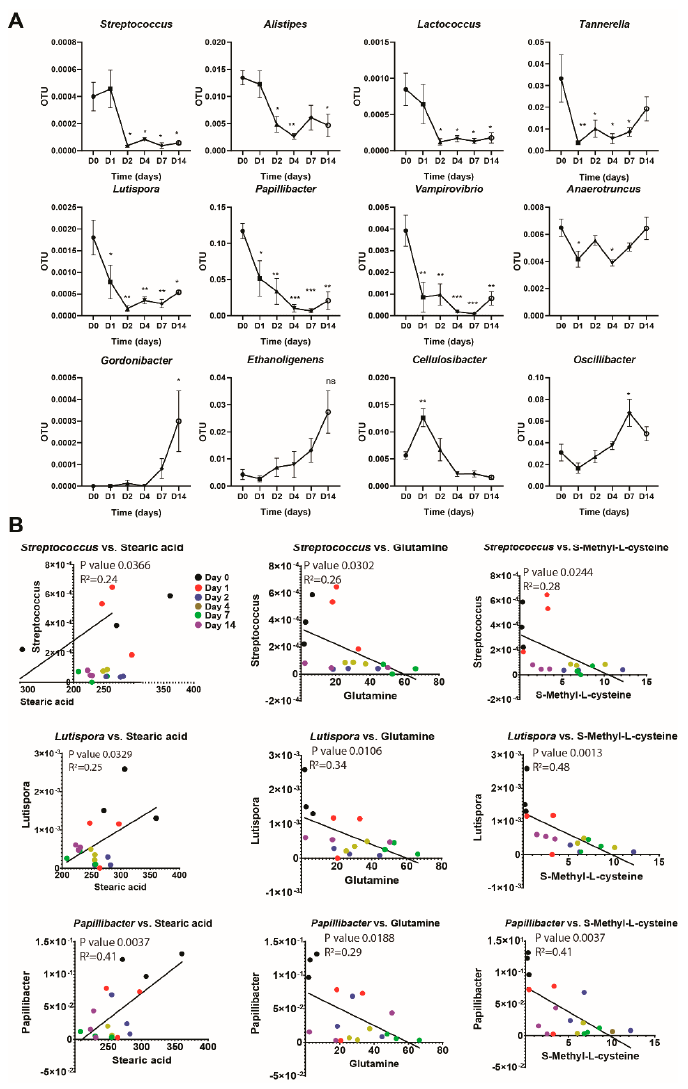
Figure 3. Changes of gut microbiota in relation to metabolite changes after broccoli feeding. ( A ) Time course of OTU change for bacteria. Unpaired t -test, Firmicutes - Lactobacillales — Streptococcus , 0 vs. 2 days, p = 0.0202; 0 vs. 4 days, p = 0.0440; 0 vs. 7 days, p = 0.0196 and 0 vs. 14 days, p = 0.0282; Bacteroidetes-Bacteroidales — Alistipes , 0 vs. 1 day, p = 0.0220; 0 vs. 4 days, p = 0.0047; and 0 vs. 14 days, p = 0.0196; Firmicutes-Lactobacillales—Lactococcus , 0 vs. 2 days, p = 0.0190; 0 vs. 4 days, p = 0.0279; 0 vs. 7 days, p = 0.0209 and 0 vs. 14 days, p = 0.0306; Bacteroidetes-Bacteroidales-Tannerella , 0 vs. 1 day, p = 0.0088; 0 vs. 2 days, p = 0.0400; 0 vs. 4 days, p = 0.0137 and 0 vs. 7 days, p = 0.0282; Firmicutes-Clostridiales—Lutispora , 0 vs. 1 day,